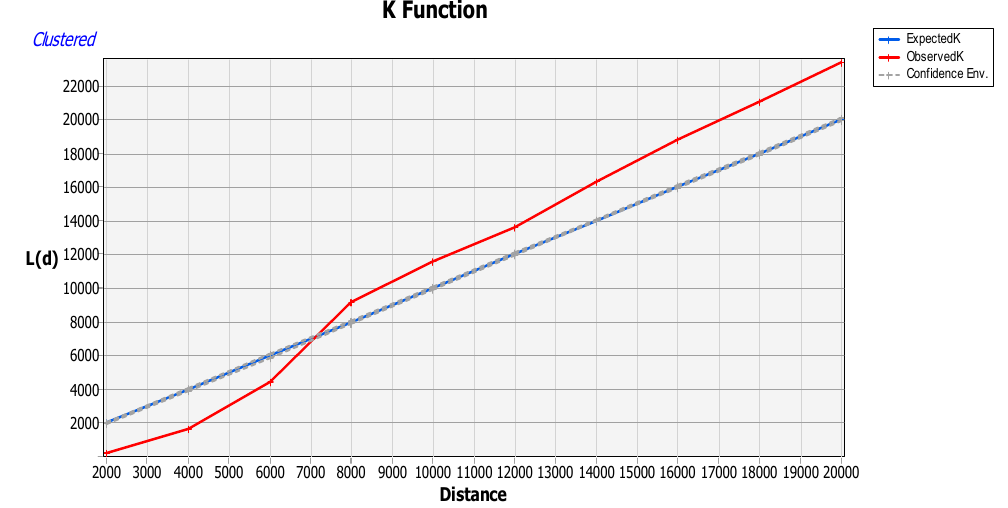
Figure 7. The arrangement of BGCPs over the range of distances (in meters). The blue line denotes the expected distance, and the red line—the observed distance.